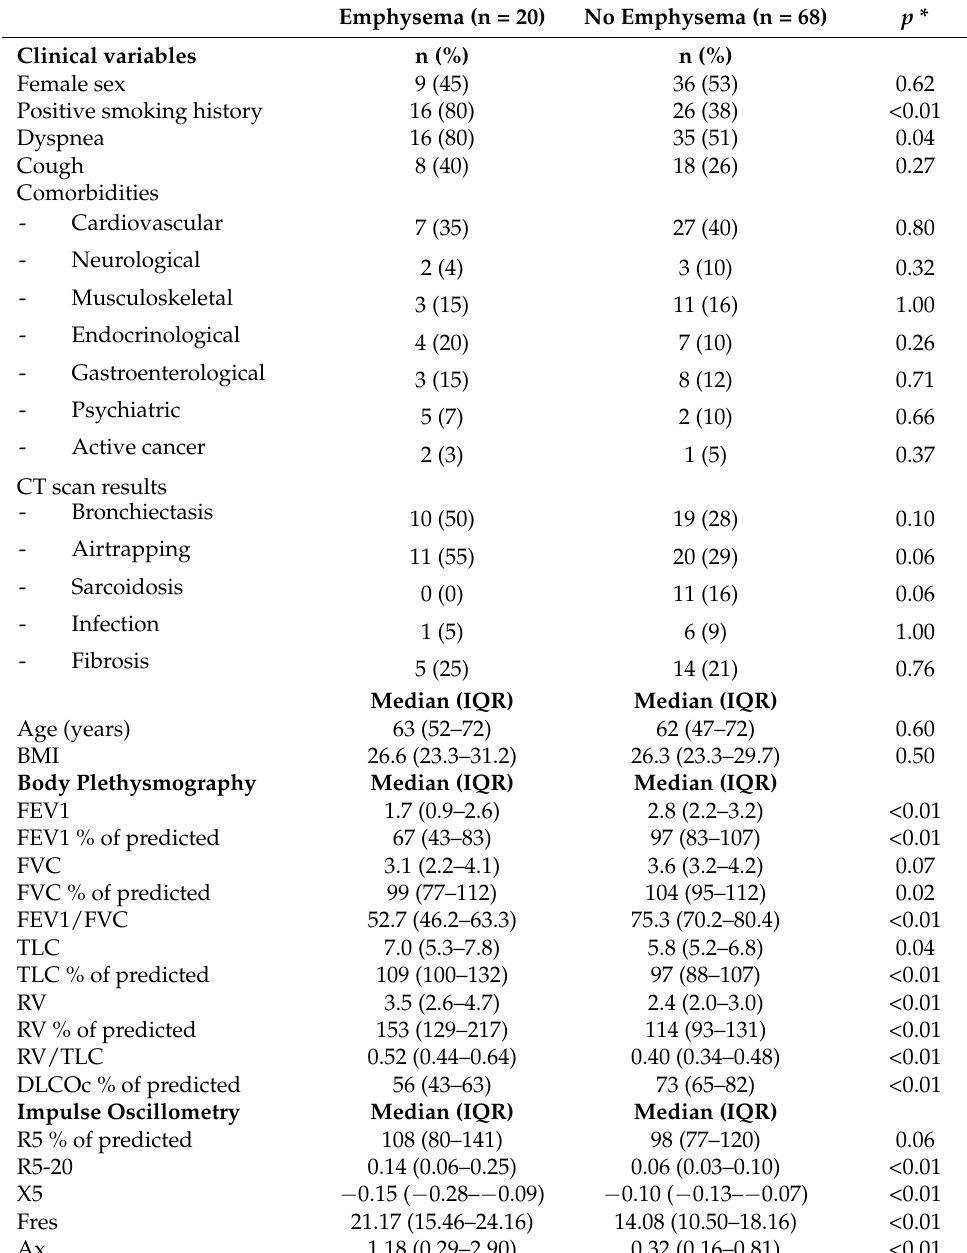
Table 1. Patient characteristics stratified on presence of